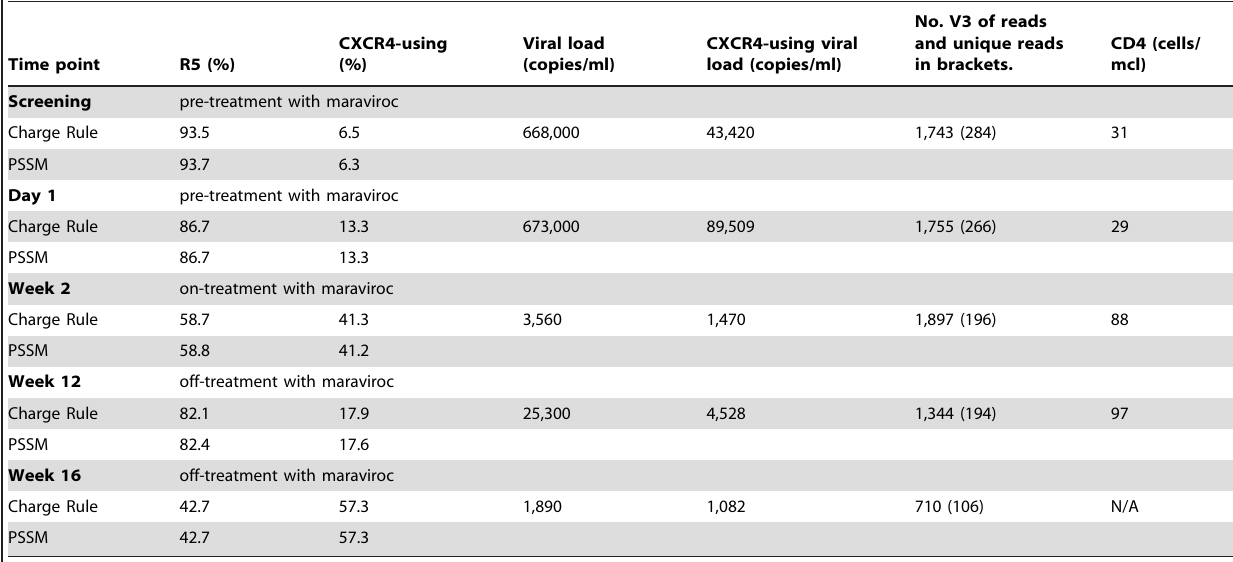
Table 3. Patient D tropism